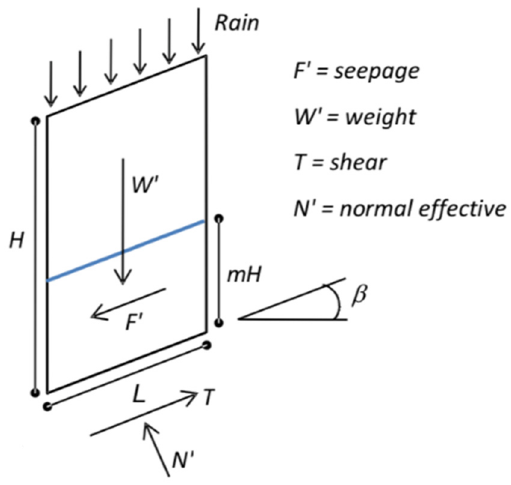
Figure 4. View of the imbibition level for the slip model in